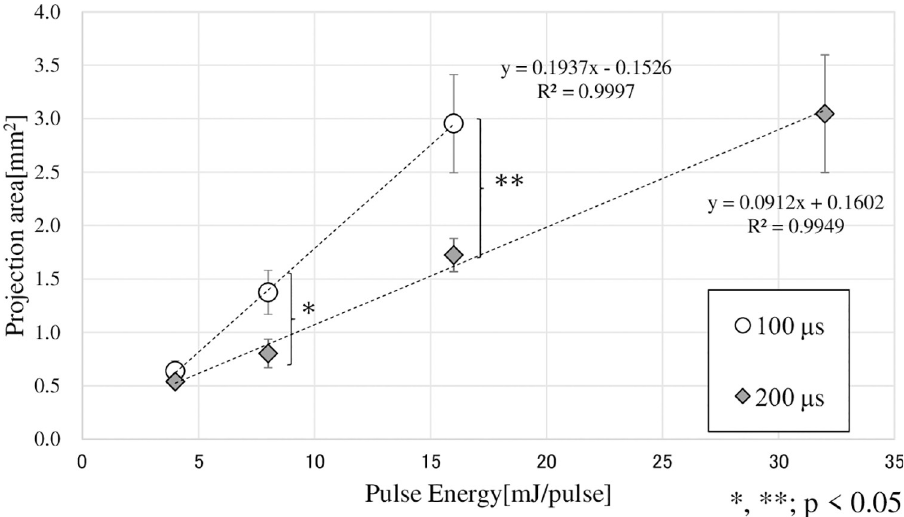
Fig 5. Relationship between irradiation energy and bubble projection area. � : pulse width = 100 μ s (N = 5), ♦ : pulse width = 200 μ s (N = 5). Horizontal axis: incident energy per pulse. Vertical axis: projected area of the bubble assuming it to be an ellipse. At both 8, 16 mJ/pulse, the bubbles that were generated with a pulse width of 200 μ s were significantly smaller than those generated with a pulse width of 100 μ s ( � , �� ; p < 0.05).